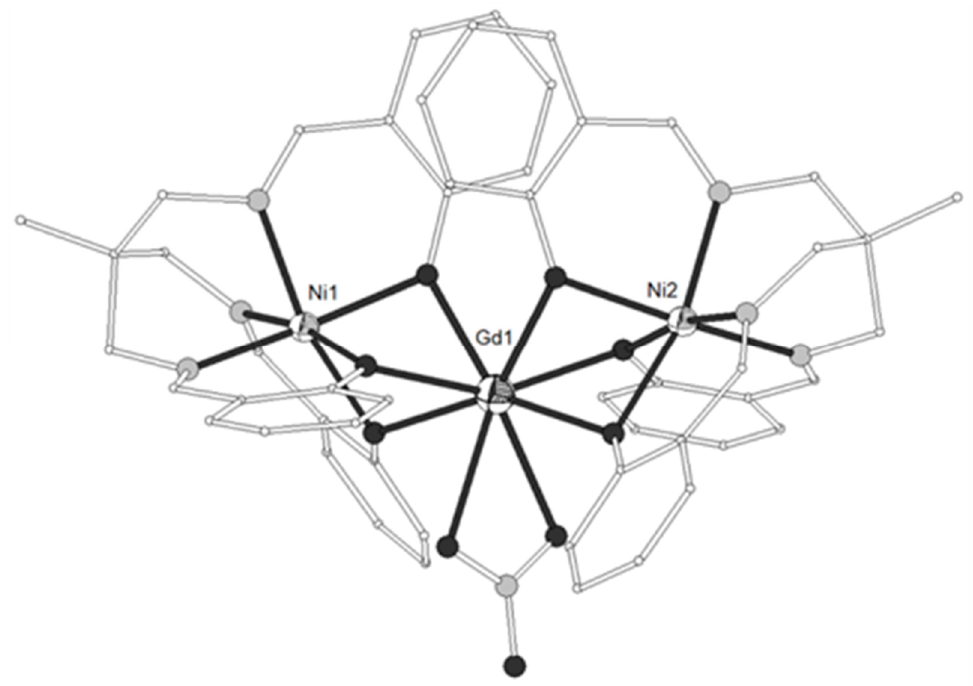
Figure 2. The molecular structure of complex [(NiL 2 ) 2 Gd(NO 3 )] ( 12 ). Color code: Gd large octant, Ni small octant, N light grey, O dark grey, C open small